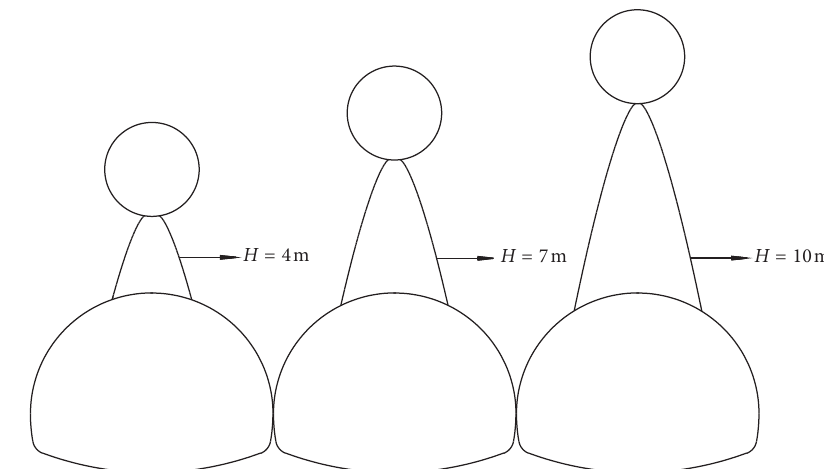
Figure 8: The shape and range of the collapse surface for different values of H